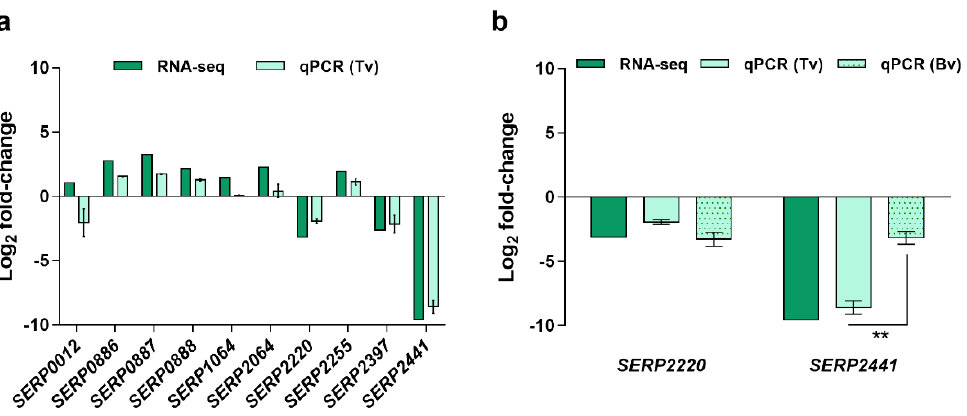
Figure 1. Validation of the results obtained by RNA-seq. Data are presented in fold-change expression calculated using commensal isolates as control. ( a ) Technical validation (Tv) was performed using the same RNA utilized for library construction. The bars represent the mean and the standard error of the mean of two to three technical replicates. ( b ) Biological validation (Bv) was accomplished using RNA obtained from independent experiments. These experiments were performed with the same three clinical and three commensal isolates used for RNA-seq. The bars represent the mean and the standard error of the mean of three independent experiments performed using the blood of three different donors ( n = 3). Statistical differences between technical and biological validations ( b ) were analyzed with the unpaired t-test. ** p < 0.001. RNA-seq, RNA sequencing, qPCR, quantitative PCR.